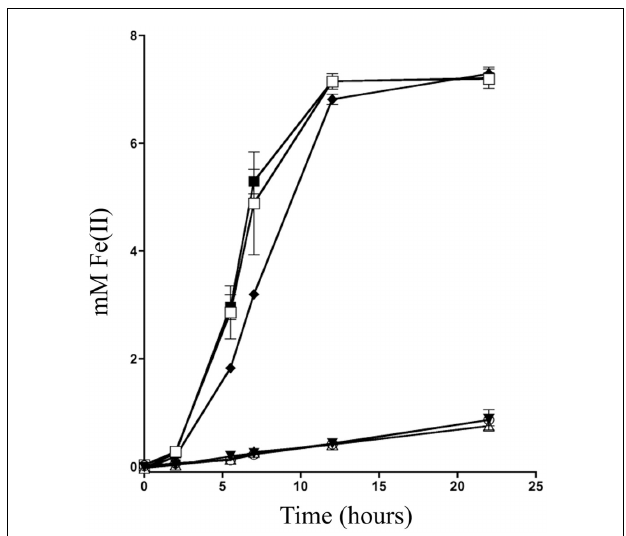
FIGURE 2 | Iron(III) citrate reduction using various mtrB paralogs. The reduction of ferric citrate over time was measured for Δ mtrB complemented with ( (cid:2) ) mtrB , ( (cid:2) ) dmsF , ( (cid:3) ) SO4359 , ( (cid:4) ) mtrE , and ( (cid:3) ) empty vector were compared to ( (cid:5) ) MR-1 with empty